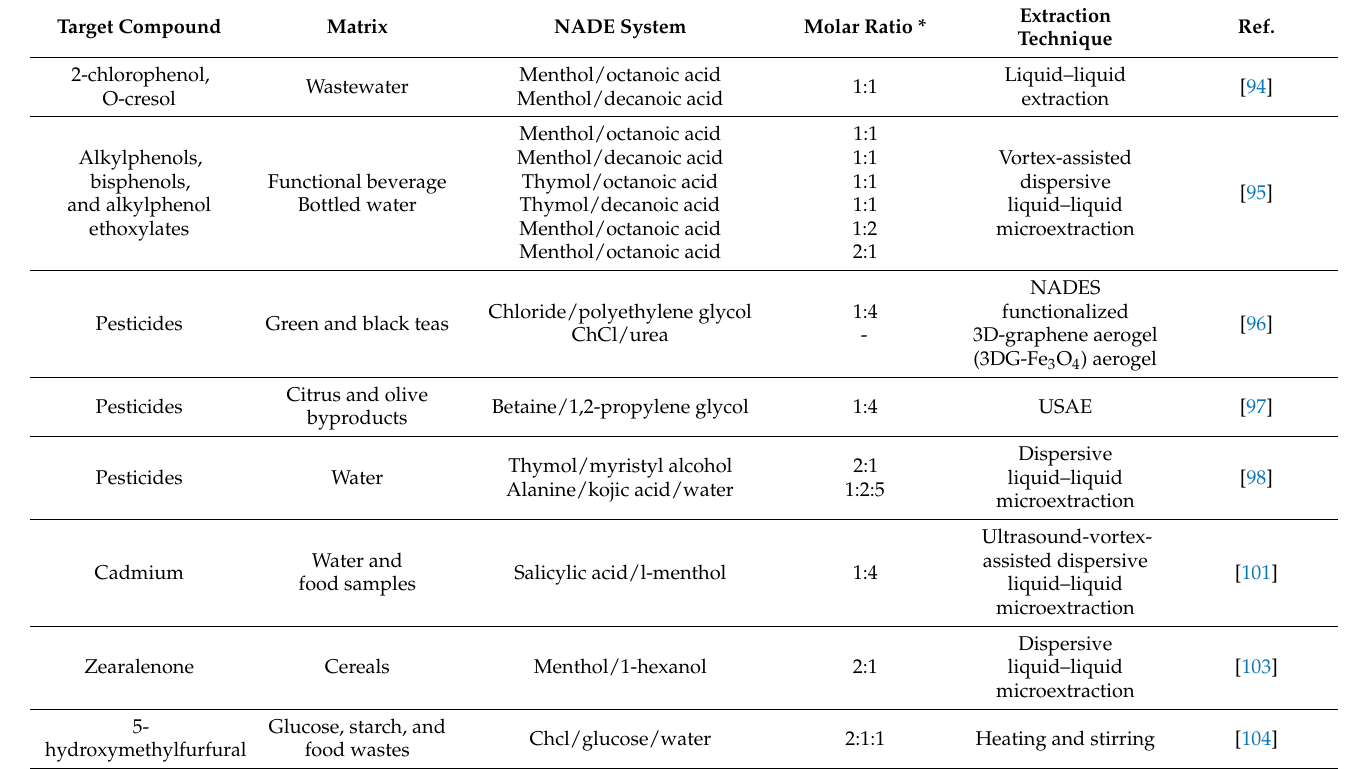
Table 4. Food safety evaluation using NADES and combined extraction